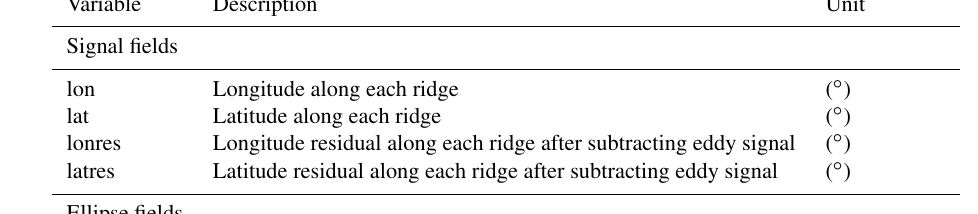
Table 1. List of output from the MWRA routine. In descriptions, a and b are the semi-major axis and the semi-minor axis of an ellipse. Variable Description